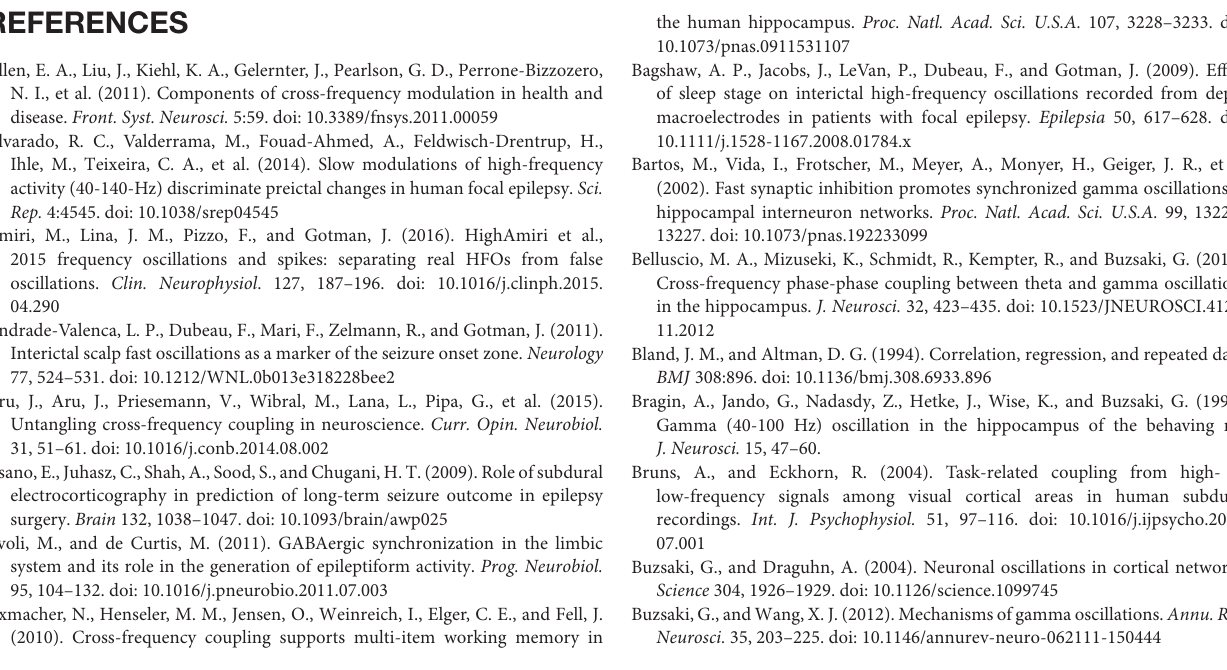
FIGURE S1 | The average coupling for 25 patients in different regions. The x-axis corresponds to low frequencies (delta, theta, alpha, beta bands) and the y-axis to the high frequencies (gamma and ripple bands). Color indicates degree of coupling and the scaling is different for each patient. Note that patients 19, 21, and 24 had no channels outside the SOZ with IEDs (blank figures). NoZ, normal zone; EIZ, exclusively irritative zone; SOZ, seizure onset zone. FIGURE S2 | Representative example of higher values of coupling in the epileptic channels compared to the normal channels. PAC in all channels of patient 5 (green box: normal zone, yellow box: exclusively irritative zone, and red box: seizure onset zone), MI, modulation